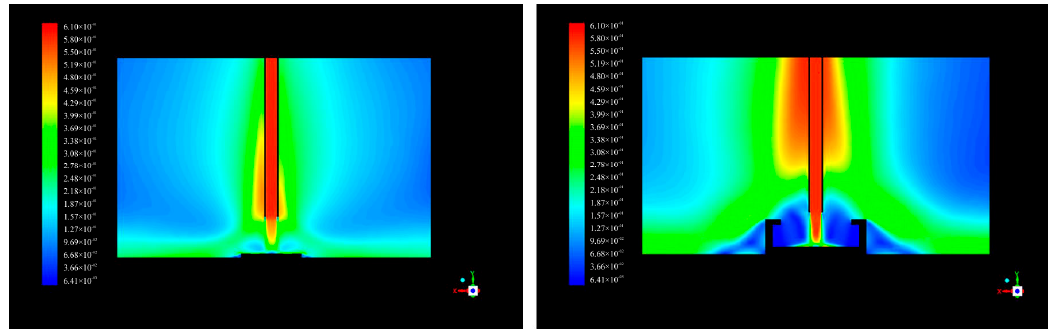
Figure 9. Graphical comparison of residence times of all tested configurations. Figure 10. Comparison of velocity areas for “Spheric” and standard impact pads @ 0.8 m · min − 1 .